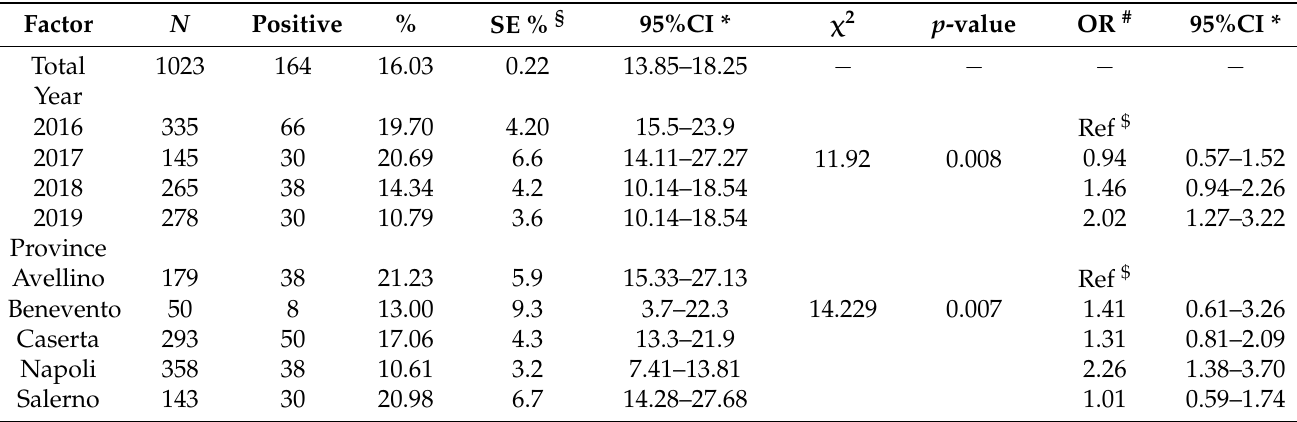
Table 2. Seroprevalence of infection with Ehrlichia spp. and risk factor analysis by region and year in stray dogs in the Campania Region in 2016–2019 as detected by qualitative dot-ELISA SNAP 4DX ® (IDEXX Laboratories). Factor